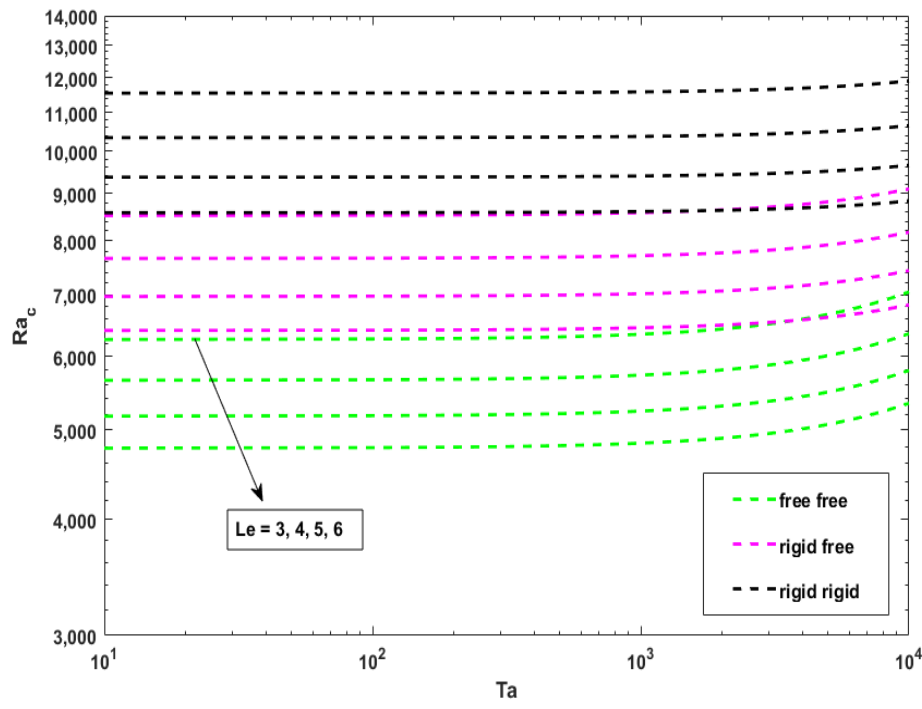
Figure 8. Variation of Ra c with Ta for Da = 0.01, Du = 0.02, Rs = 200, Sr = 0.2, Λ = 8, M = 0.9, ϕ = 0.9.